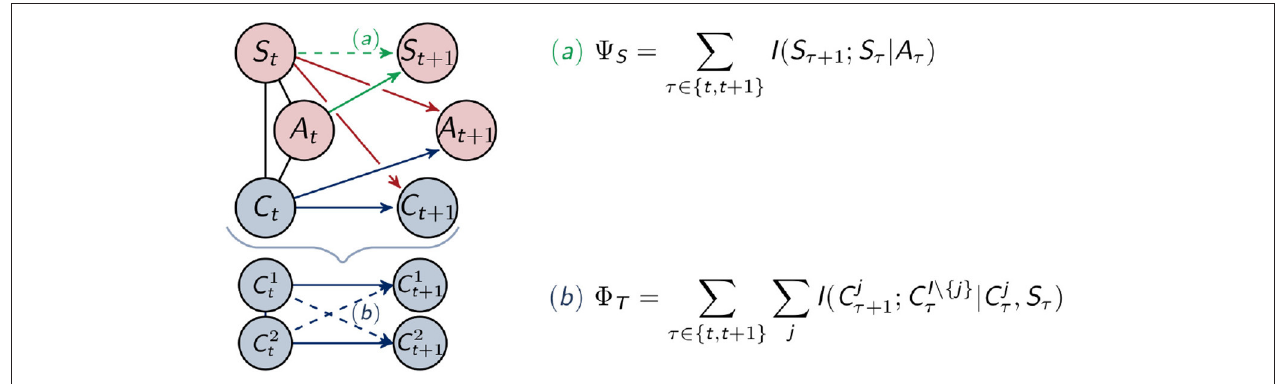
FIGURE 5 | Calculation of the measures for morphological computation (a) and integrated information